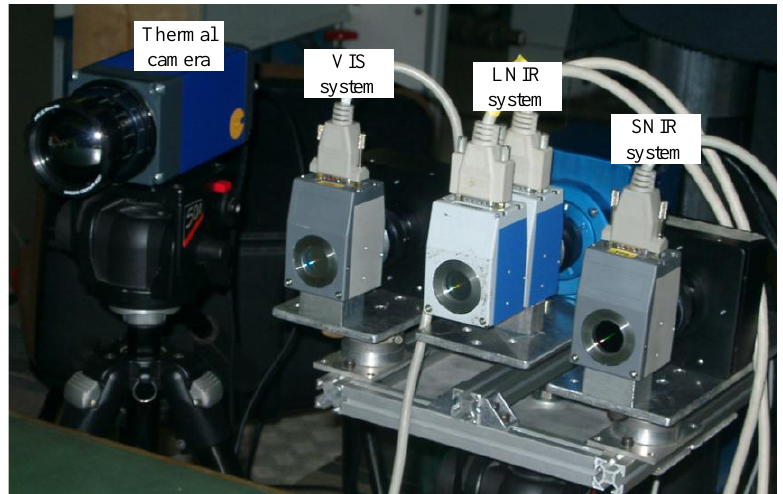
Figure 2. Picture of the hyperspectral apparatus: VIS system stands for Dalsa camera-VIS filter coupling; SNIR system for Dalsa camera-SNIR filter coupling and LNIR system for Xeva Xenics camera-LNIR filter